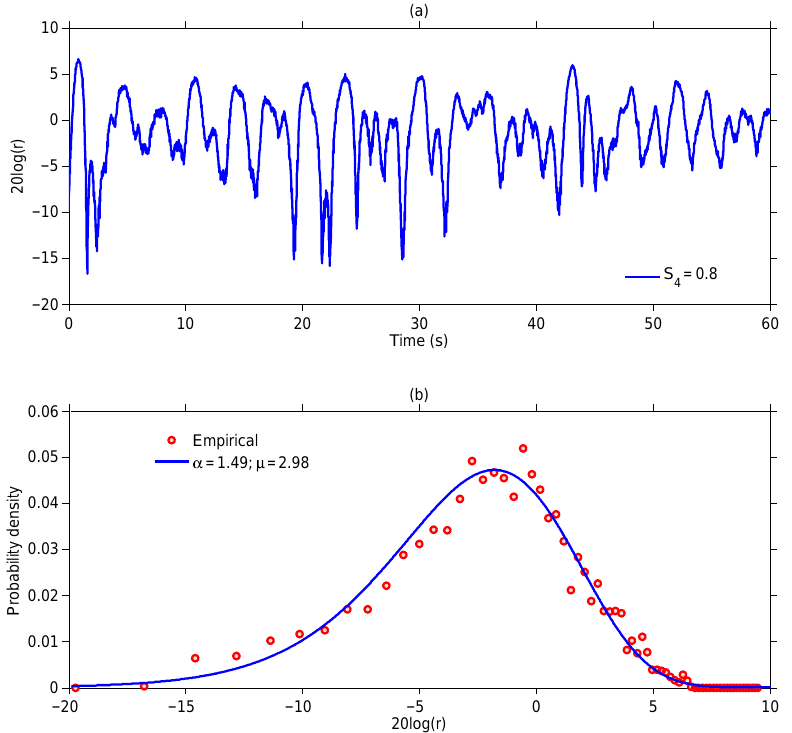
Figure 6. (a) Case of amplitude scintillation with S 4 = 0 . 8 for satellite PRN2 on 4 February 2000. (b) Theoretical α − µ model based on the moment estimation of Eq. (4) in comparison with the measured occurrences from panel (a)